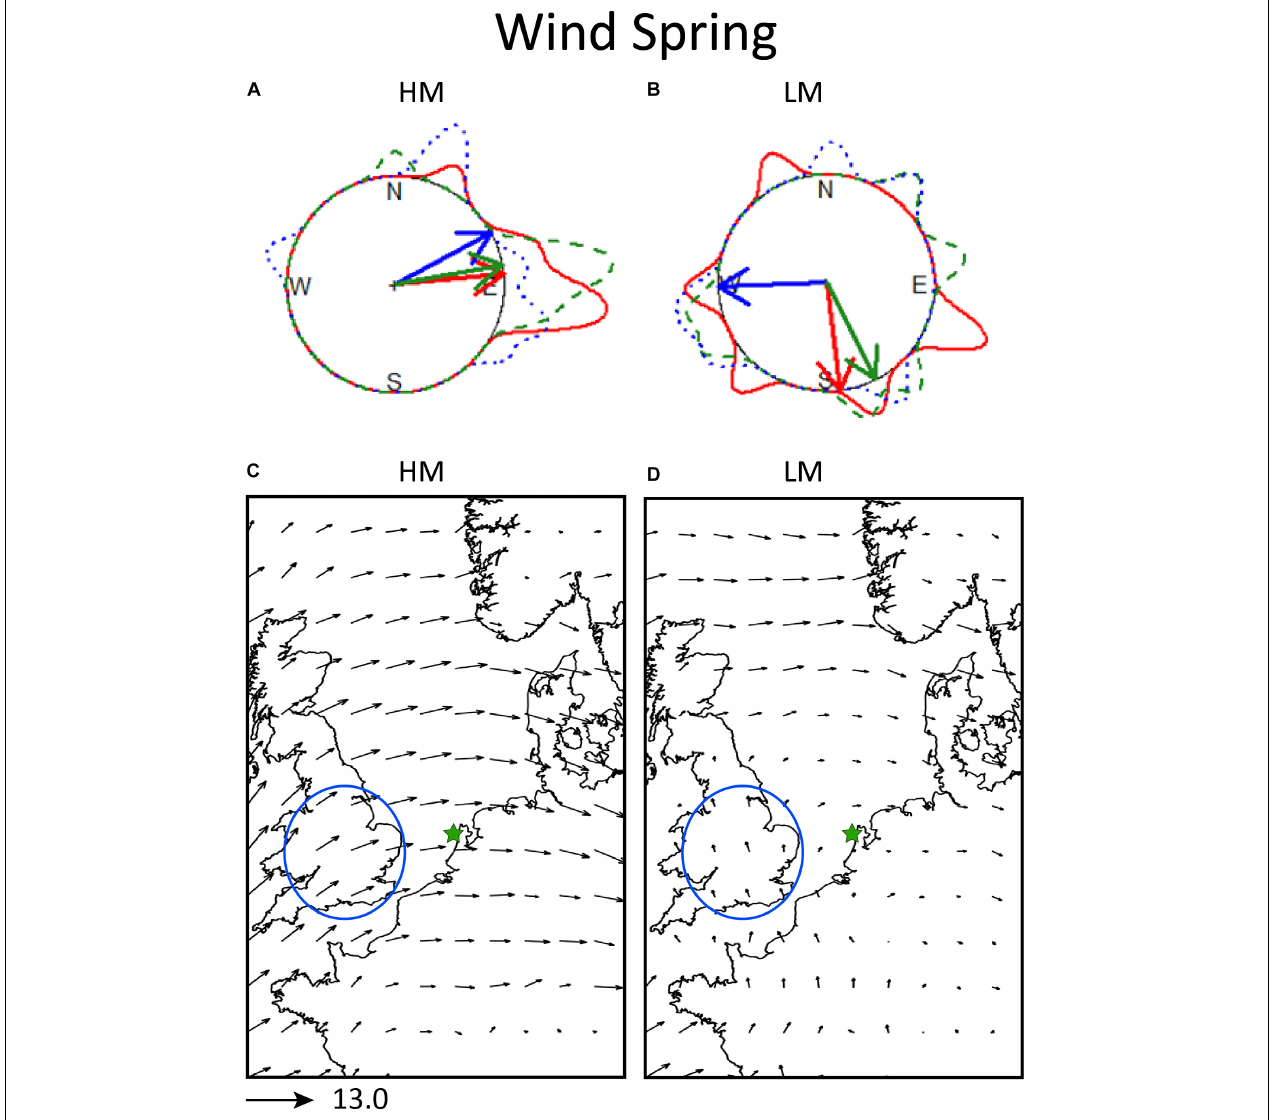
FIGURE 2 | Local and synoptic 925 hPa winds in spring. Top panel: Inside each circle, the mean heading of the birds (red arrows), mean 925 hPa wind direction at the radar location (blue arrows), and mean track direction of the birds (green arrows). Around the circle, the circular density distributions of bird heading (solid line), wind direction (dotted line), and track direction (dashed line), in panel (A) for nights of high migration intensity (HM) and in panel (B) for nights of low migration intensity (LM). Bottom panel: synoptic 925 hPa wind conditions in spring, in panel (C) for nights of high migration intensity (HM) and in panel (D) for nights of low migration intensity (LM). The length of the arrows is proportional to the strength of the averaged wind. As a reference the length of the arrow of 13 m/s wind strength is given under the panels. The circled area designates the most probable area of departure for the detected flying migrants during those nights. The star designates the location of the